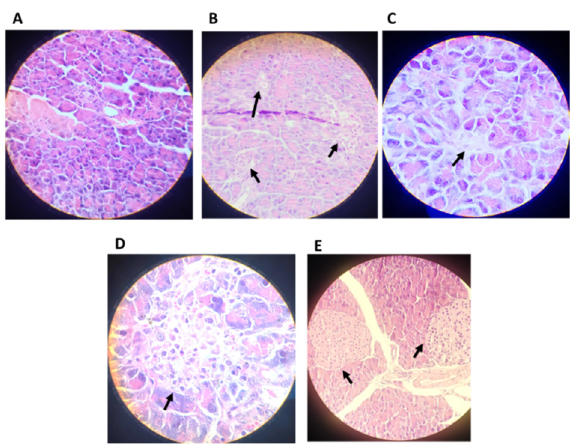
Figure 7. Effect of the butanol fraction from calyces of P. peruviana on pancreatic islets at 50 mg/kg and 100 mg/kg. ( A ) Untreated diabetic group (vehicle); ( B ) normal control group; ( C ) diabetic group treated with metformin; ( D ) diabetic group treated with BFPP 50 mg/kg; ( E ) diabetic group treated with BFPP 100 mg/kg. Micrographs were stained with H&E, with a magnification of 40× and 100×. Arrows shows the presence of Langerhans islets.